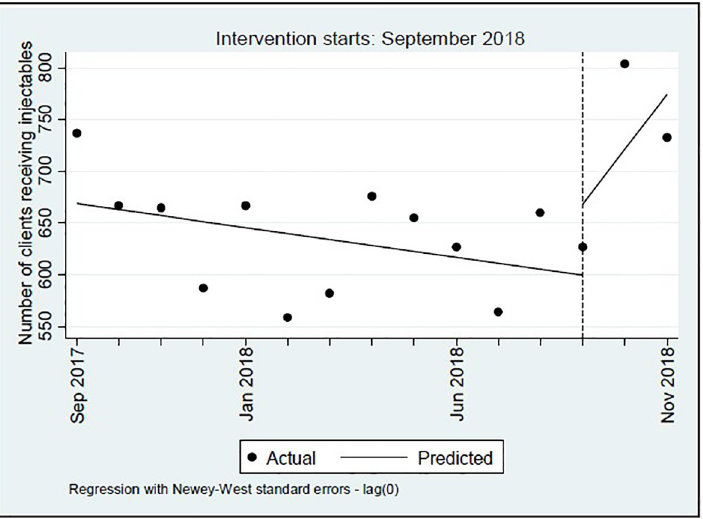
Fig 3. Graph of total number of Depo-Provera clients per month in the ten pilot intervention facilities from September 2017 through November 2018, Tanzania 2018.